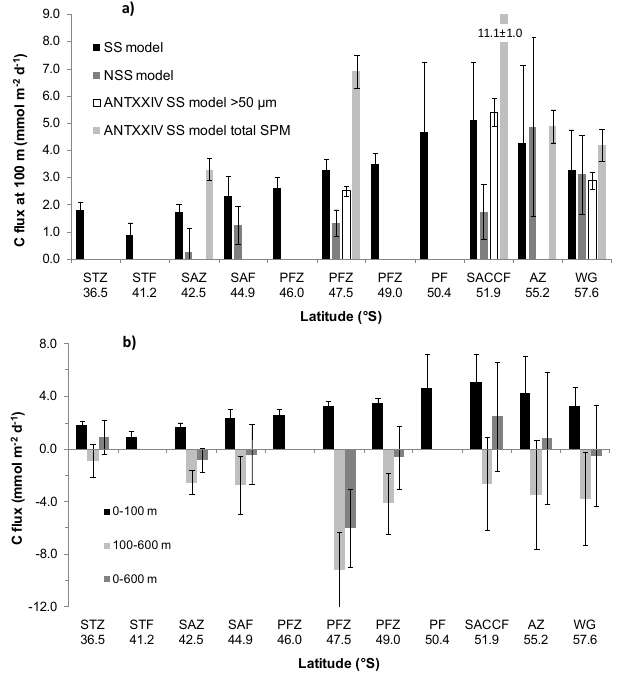
Fig. 7. (a) 100m-POC export fluxes (mmolm − 2 d − 1 ) estimated us- ing SS and NSS models and comparison with export fluxes from 100m for > 50µm particles and total suspended material reported for the ANTXXIV cruise (Rutgers van der Loeff et al., 2011). (b) Comparison of the POC export flux from the upper 100m; the POC flux between 100–600m (deduced from the 234 Th excess activity), and the total integrated POC export from the upper 600m depth using the SS